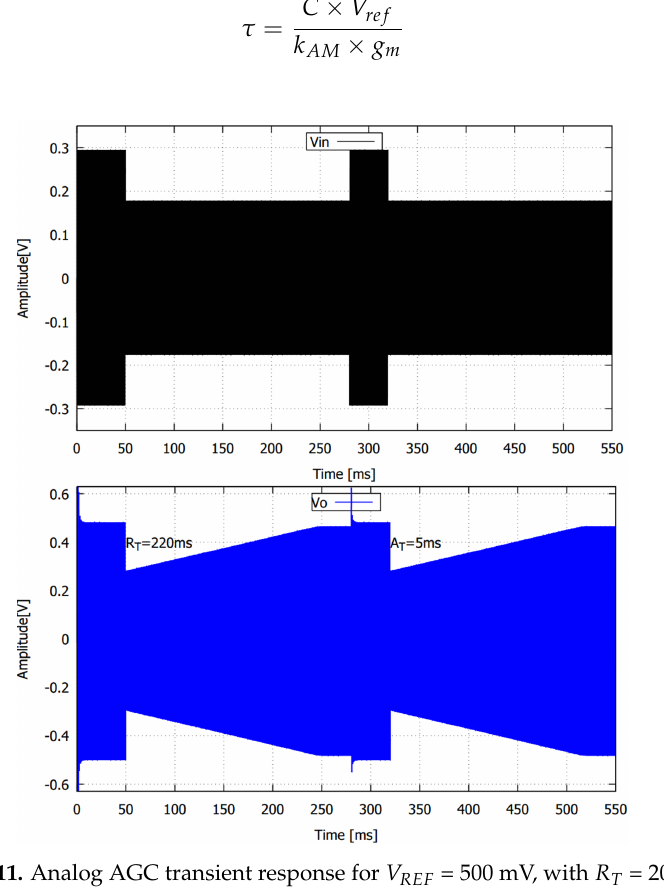
Figure 11. Analog AGC transient response for V REF = 500 mV, with R T = 200 ms.